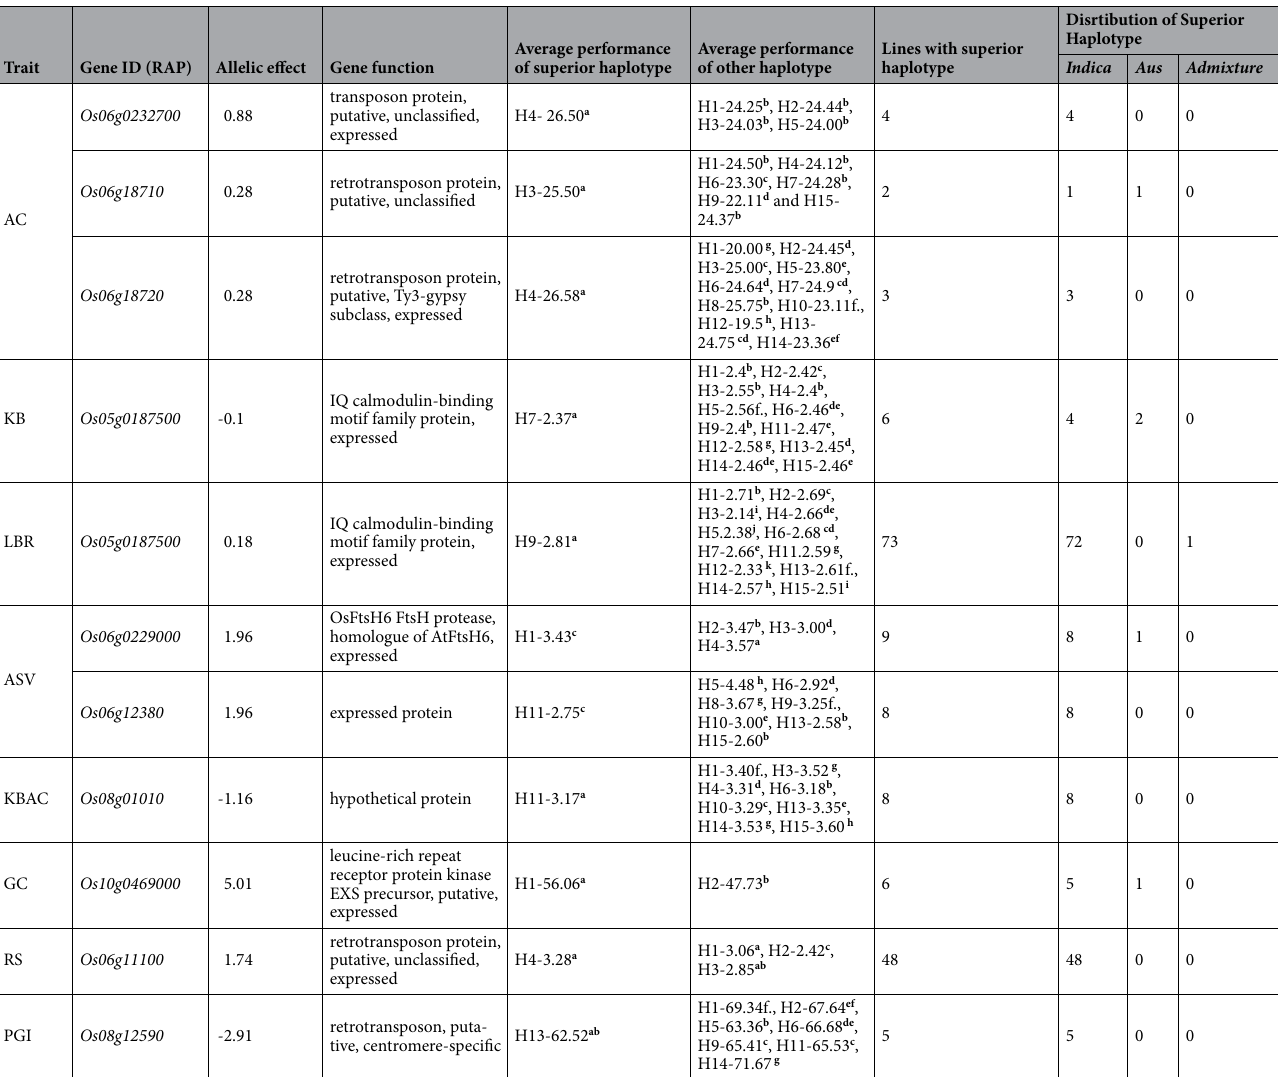
Table 2. Haplo-pheno analysis of favourable candidate loci for grain quality traits, RS content and predicted glycemic index in rice. AC—Amylose content, KL—Kernel length, KB—Kernel breadth, LBR—Length/ Breadth ratio, ASV—Alkali spreading value, KLAC—Kernel length after cooking, KBAC—Kernel breadth after cooking, LER—Linear elongation ratio, GC—Gel consistency, RS—Resistant starch, PGI—Predicted glycemic index, TPR—Transplanted